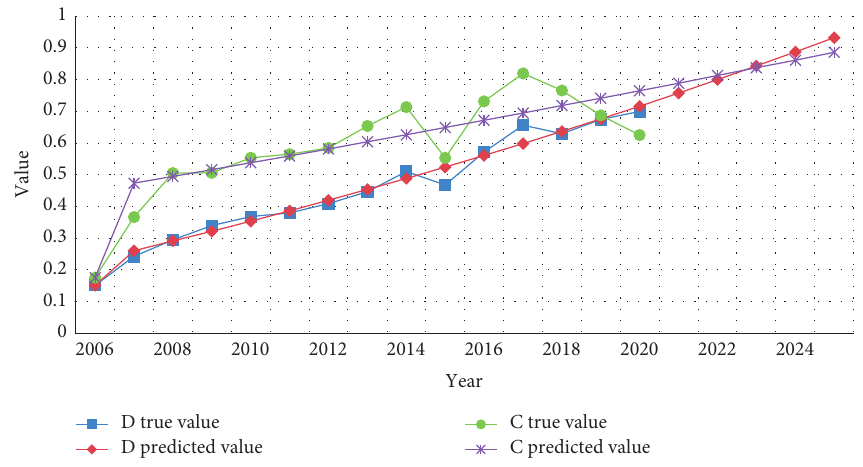
Figure 2: Forecasting trends in